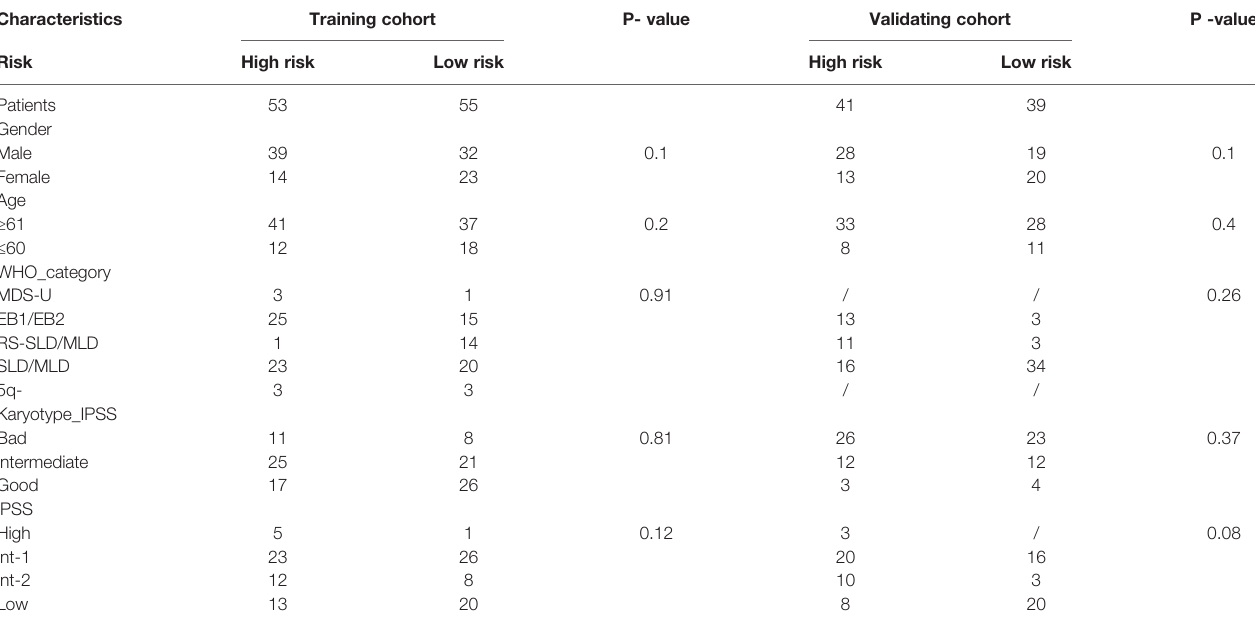
TABLE 1 | The detailed patient characteristics of training cohort and external validation cohort in MDS.